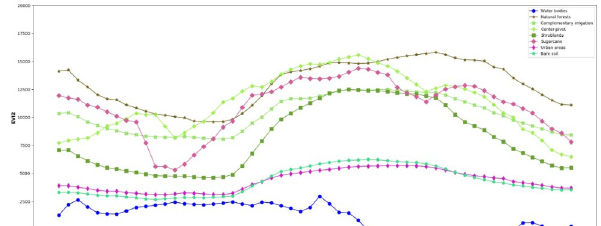
Figure 2 . EVI2 curves, obtained for the points of the samples used in the training model.